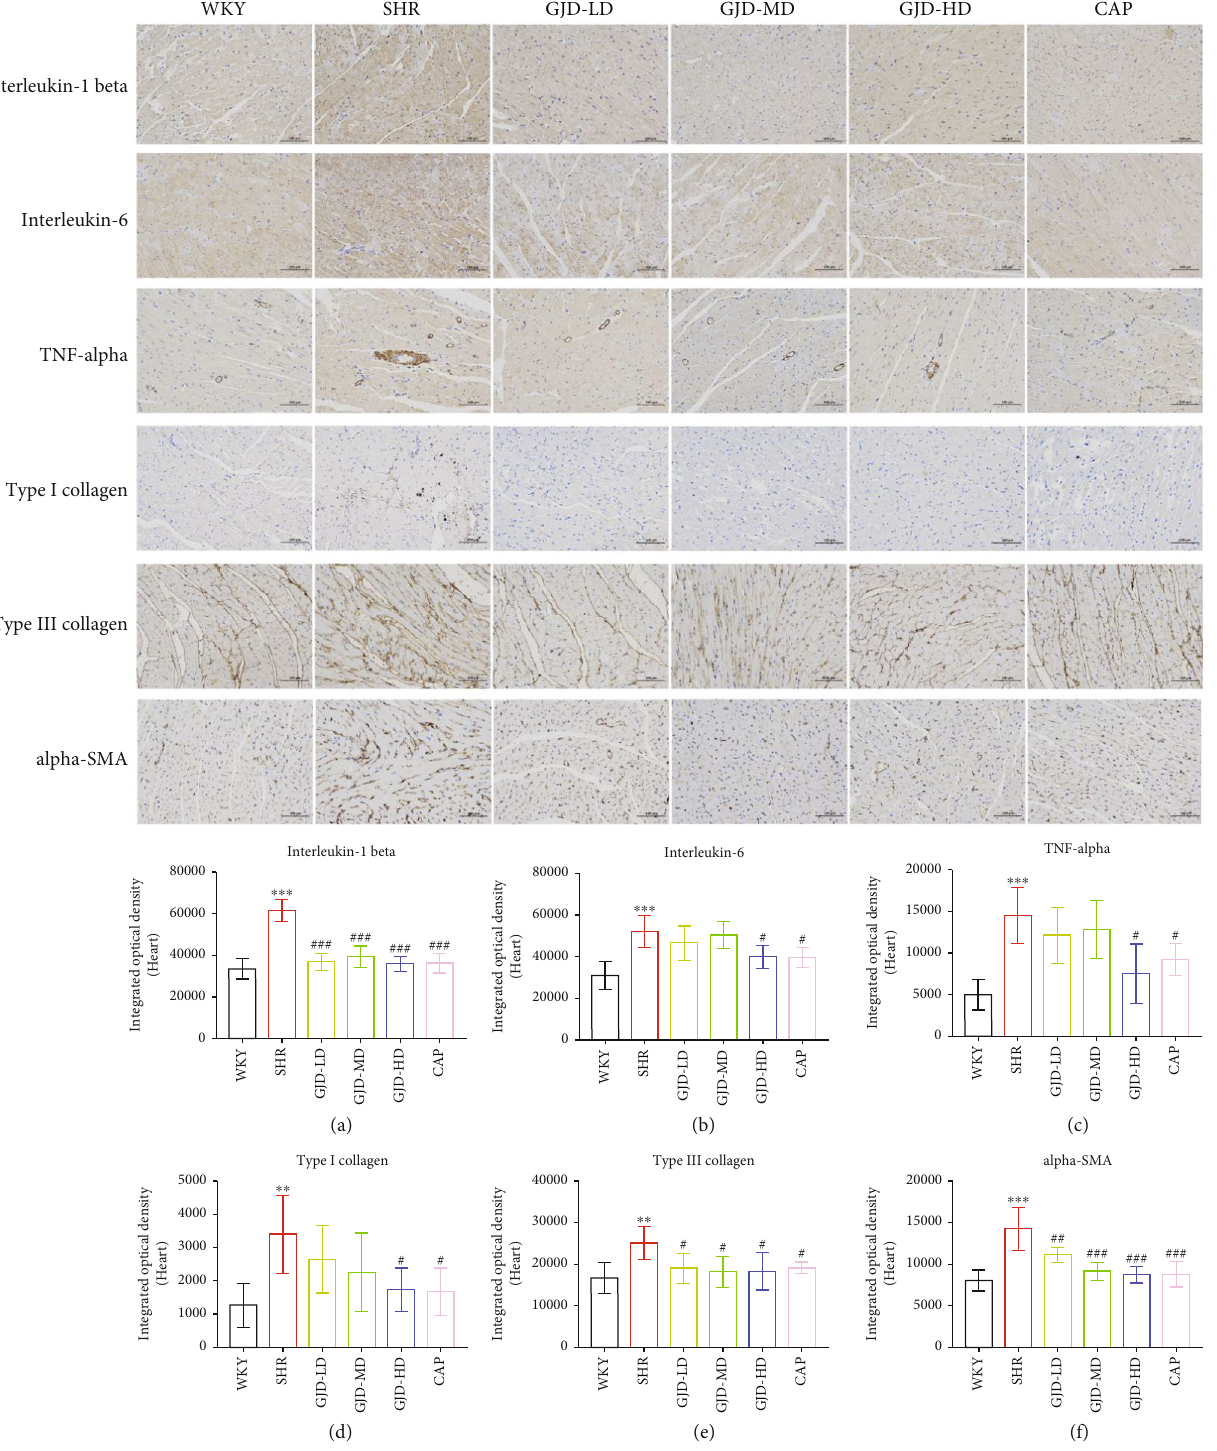
Figure 7: In the left ventricular, immunohistochemistry sections and quanti fi cation of protein expressions of interleukin-1 beta, interleukin- 6, TNF-alpha, type I collagen, type III collagen, and alpha-SMA. (A) Interleukin-1 beta, (B) interleukin-6, (C) TNF-alpha, (D) type I collagen, (E) type III collagen, and (F) alpha-SMA. The images were taken at a magni fi cation of × 200. Scale bar =100 μ m. WKY indicates the WKY control group, SHR indicates the SHR model group, GJD-LD indicates the SHR treated with GJD at a low dose, GJD-MD indicates the SHR treated with GJD at a medium dose, GJD-HD indicates the SHR treated with GJD at a high dose, and CAP indicates SHR treated with captopril. Data are means ± SD . n = 7 . ∗ P < 0 : 05 , ∗∗ P < 0 : 01 , ∗∗∗ P < 0 : 001 vs. WKY group, # P < 0 : 05 , ## P < 0 : 01 , ### P < 0 : 001 vs. SHR